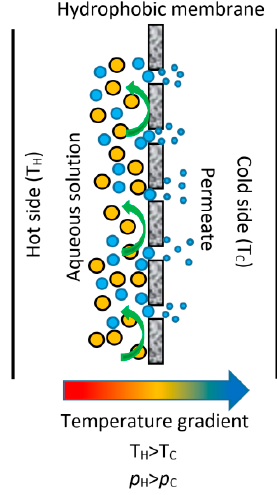
Figure 2. Basic membrane distillation (MD) configuration.